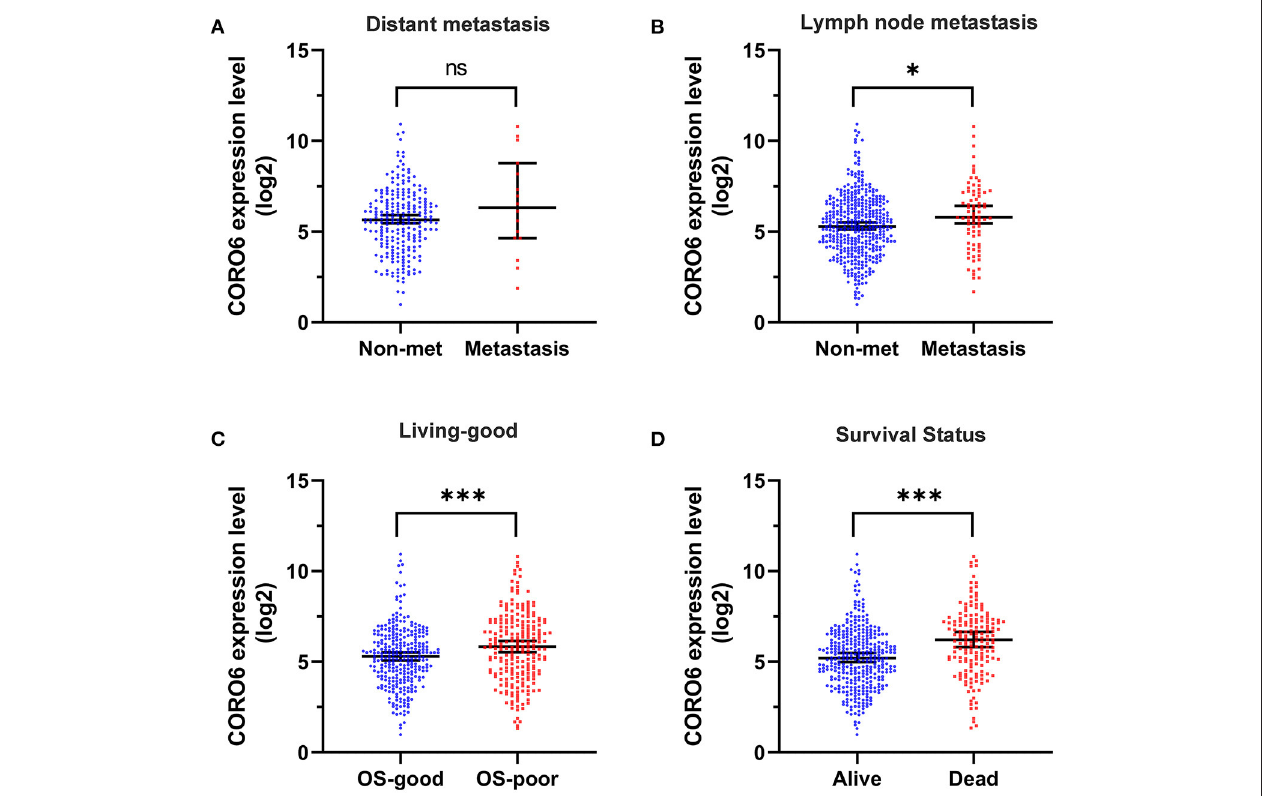
FIGURE 2 | High CORO6 level was an independent predictor of poor prognosis in ccRCC patients. A high expression level of CORO6 is strongly associated with tumor metastasis (A,B) , poor OS (C) , and death (D) . * P < 0.05 and *** P < 0.001. Ns, no significance.